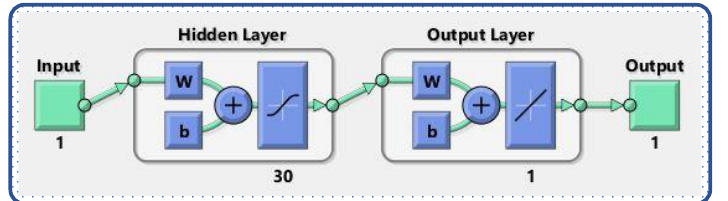
Figure 4. Structure of the supervised neural network